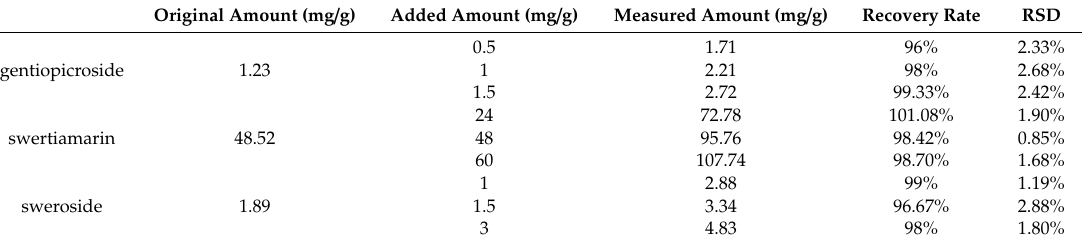
Table 3. The recovery rate of gentiopicroside, swertiamarin, and